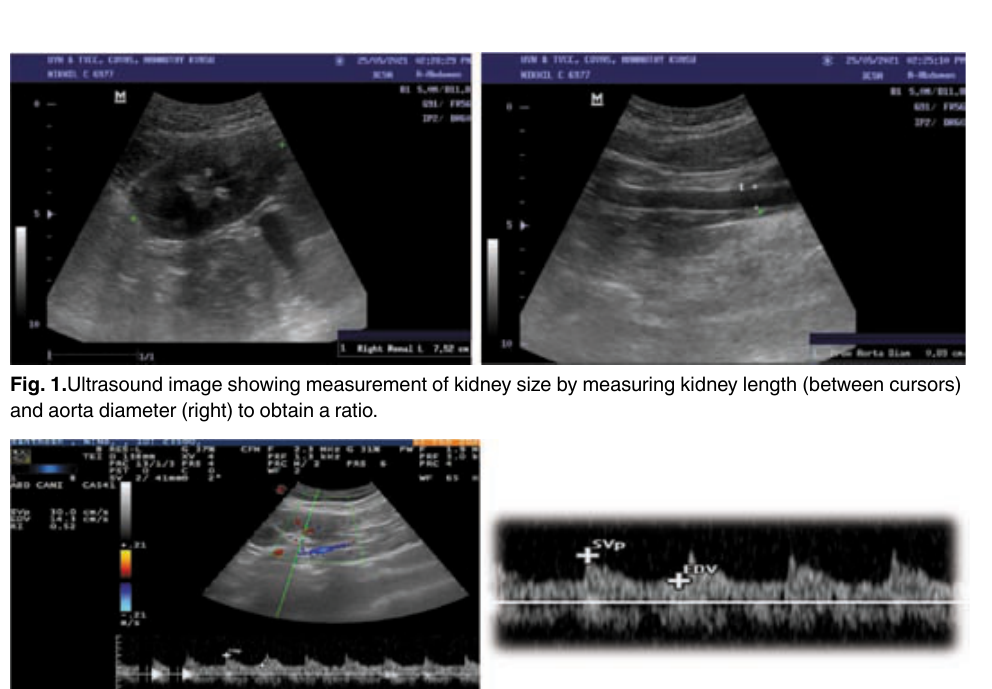
Fig. 2. Pulsed wave Doppler ultrasound image showing sample location (interlobar artery) in a healthy dog (Left) and right image showing delimitation of peak systolic velocity (PSV) and end diastolic velocity (EDV) from pulsed